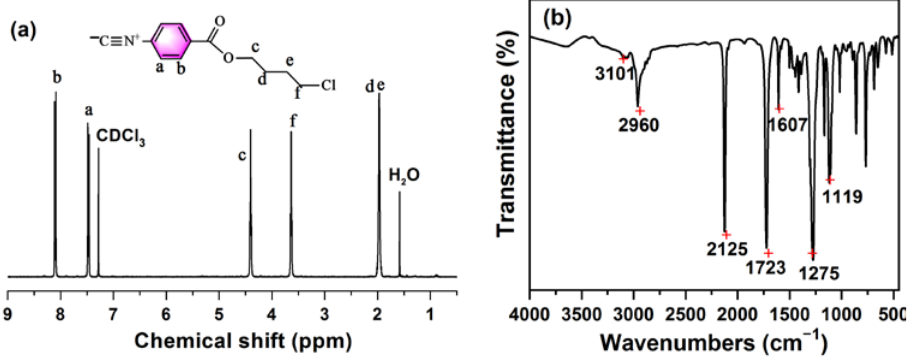
Figure 4. ( a ) 1 H NMR and ( b ) FT-IR spectra of isonitrile monomer (The + in the graph represents the peak position).